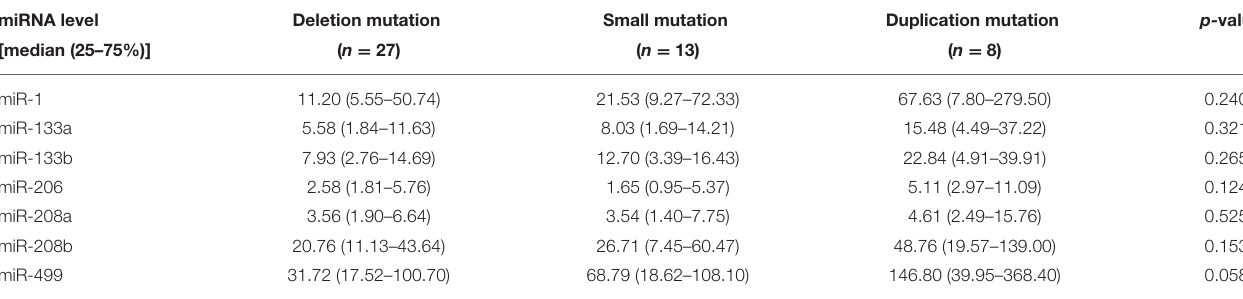
TABLE 8 | Comparison of serum miRNA levels in DMD patients with different gene mutations. miRNA level Deletion mutation Small mutation Duplication mutation p-